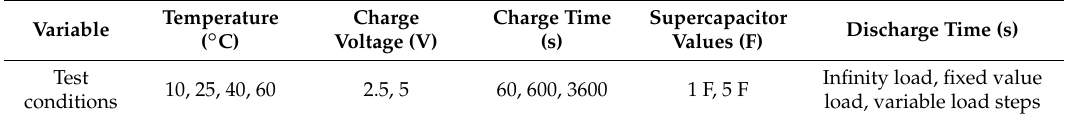
Table 1. List of variables and test